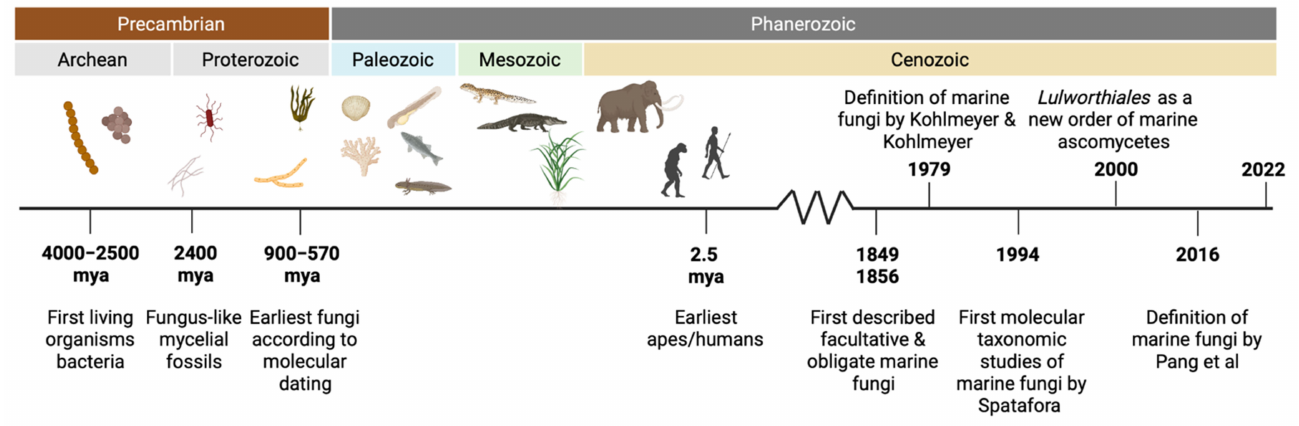
Figure 1. Timeline showing important events concerning marine fungi taxonomy. Mya: millions of years